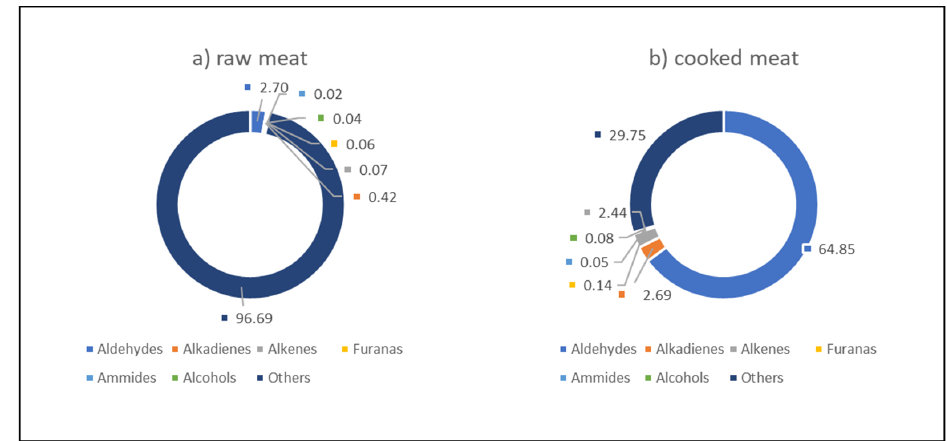
Figure 13. Main VOC classes (%) in raw ( A ) and cooked ( B ) chicken meat. Modified by [47]. VOC: volatile organic compound. Table 7. Influence of genetic strains and processing (raw vs. cooked) on the VOC production (ppb), fatty acid (mg/g DM), and antioxidants (g/g DM) content of poultry meat. Modified by [47]. Compounds RAW COOKED Pooled SE